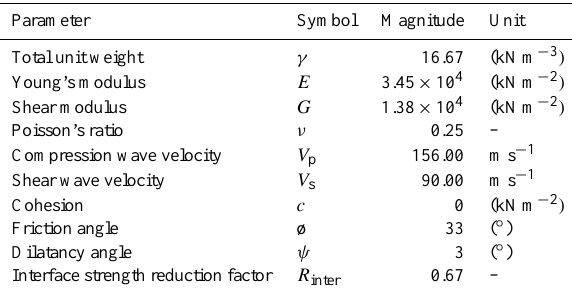
Fig. 6. Variation of lateral displacement time histories at the roof floor of the buildings under consideration of SSI (dashed curves) and fixed-base support (solid curves) in the case of H/D = 0.4 with different soil conditions for the 1989 Loma Prieta earthquake input motion. Table 5. Material parameters for superstructure considered in FE analysis.